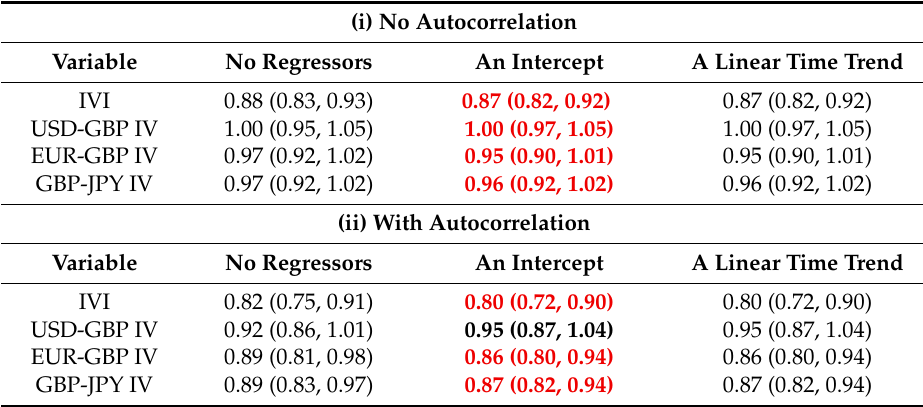
Table 1. Estimates of d for the whole sample based on parametric